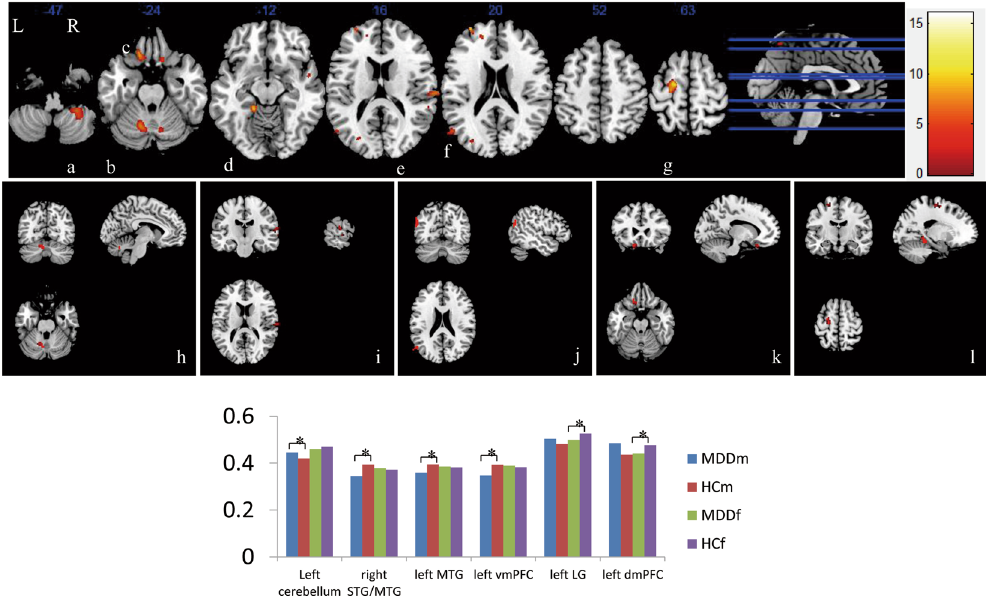
Figure 1. Sex by diagnosis interaction in GMV maps. Significant sex by diagnosis interaction was found in A: right cerebellum, B: left cerebellum, C: left ventral medial prefrontal gyrus (rectal gyrus), D: lingual gyrus, E: right middle/superior temporal gyrus, F: left middle temporal gyrus, and G: left dorsal medial prefrontal gyrus. Simple effect analysis suggested that male patients with MDD showed selective GMV increase in the left cerebellum ( a ) and reduction in the right superior/middle temporal gyrus ( b ), left middle temporal gyrus ( c ) and left ventral medial prefrontal gyrus ( d ), while female MDD patients showed selective GMV reduction in the left lingual gyrus ( e ) and dorsal medial prefrontal gyrus ( e ). The bar chart indicates the average GMV of regions with alterations. * Represents a significant difference detected. L, left hemisphere; R, right left hemisphere.